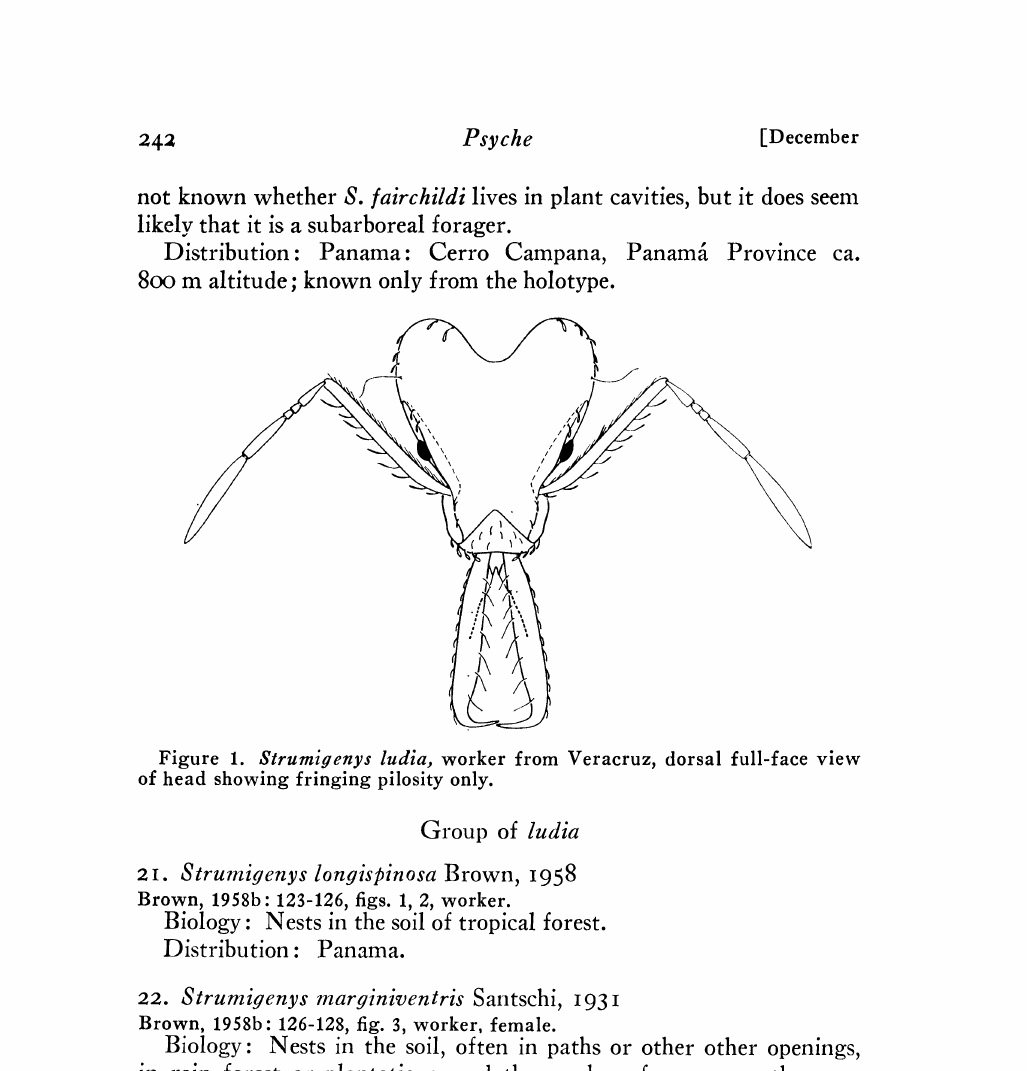
Figure 1. Strumitlenys ludia, worker from Veracruz, dorsal full-face view of head showing fringing pilosity only. Group of ludia 2. 8trunigenys longisI)inosa Brown,